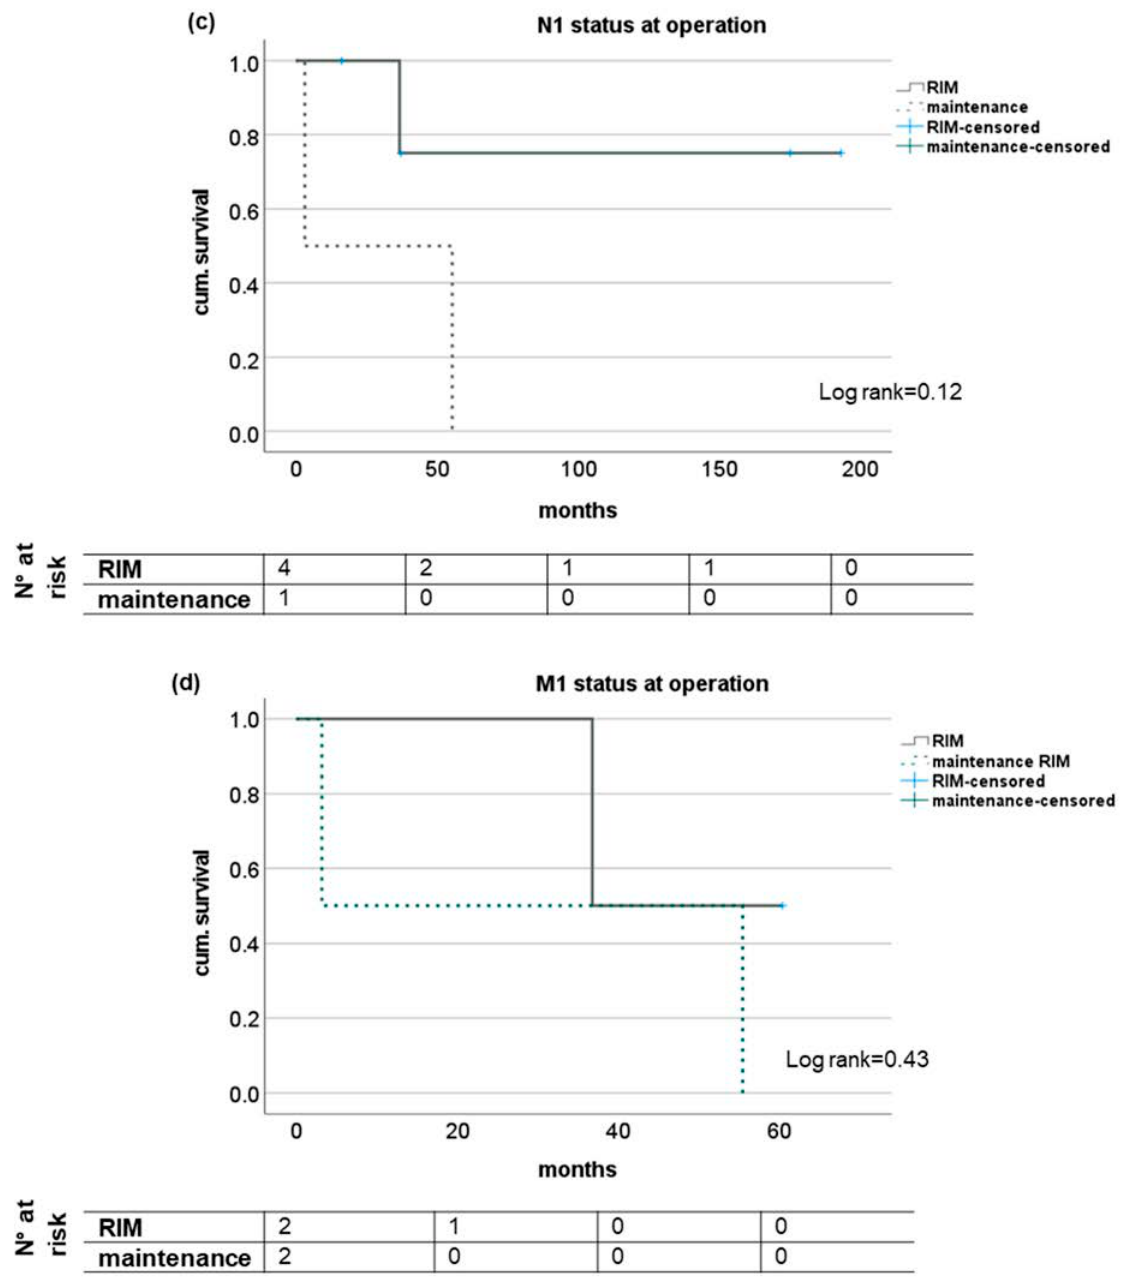
Figure 2. Subgroup analysis of survival of patients with and without RIM dependent on lymph node manifestation or distant metastases at time of diagnosis of CRC after LT. Kaplan-Meier analysis of patients without tumor manifestations in lymph nodes ( a ) or distant metastases ( b ) as well as patients with histological proven tumor manifestation in local lymph nodes ( c ) or distant metastases ( d ) at initial diagnosis of CRC seem to profit from a additional restrictive immunosuppressive regimen upon diagnosis but no statistical significant difference was reached. RIM—restrictive immunosuppressive management.